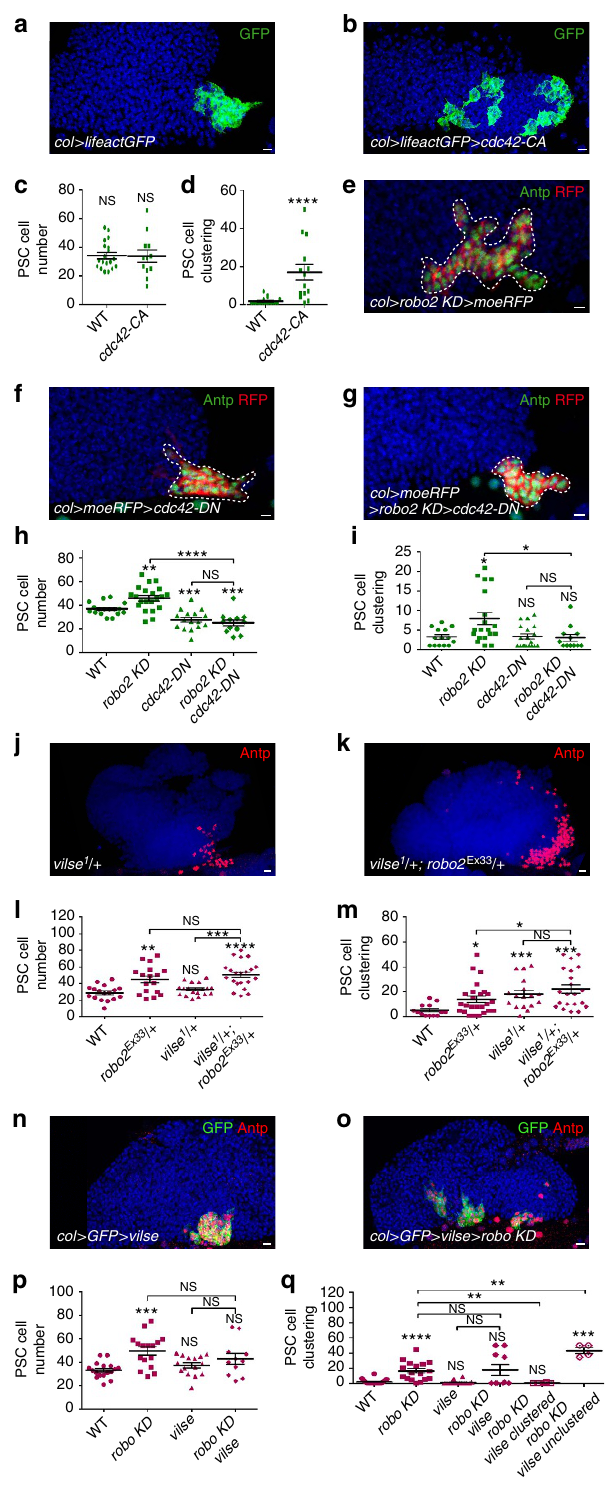
Figure 6 | Robo receptors control PSC cell clustering by repressing Cdc42 activity. ( a , b ) LifeactGFP (green) is expressed in PSC cells under the control of the col driver ( col 4 ) ( a ) and co-expressed with a constitutive form of Cdc42 (cdc42-CA) ( b ). ( c , d ) Quantification of PSC cell numbers ( c ) and PSC cell clustering ( d). ( e – g ) Antp (green) and RFP (col 4 moeRFP, red) label PSC cells in robo2 KD ( e ), when a dominant negative form of Cdc42 ( cdc42-DN ) is expressed ( f ) or when robo2 KD and cdc42-DN are co- expressed in the PSC ( g ). While the expression of cdc42-DN has no major effect on PSC cells ( f ), its co-expression in robo2 KD ( g ) rescues the robo2 KD PSC defect ( e ). ( h , i ) Quantification of PSC cell numbers ( h ) and PSC cell clustering ( i ). ( j , k ) Antp (red) labels PSC cells in vilse 1 / þ heterozygous mutant ( j ) and in vilse 1 / þ ; robo2 Ex33 / þ trans -heterozygous mutant ( k ). ( l , m ) Quantification of PSC cell number ( l ) and PSC cell clustering ( m ). A PSC cell clustering defect is observed in vilse 1 / þ heterozygous mutant. ( n , o ) Antp (red) labels PSC cells in col 4 vilse ( n ) and col 4 vilse 4 robo KD ( o ). ( p , q ) Quantification of PSC cell numbers ( p ) and PSC cell clustering ( q ). Averaging the clustering of all col 4 robo KD 4 vilse , LGs does not reveal a significant clustering defect (Fig. 6q). However, these LGs ( n ¼ 10 lobes) can be divided into two classes: clustered (60%) and unclustered (40%), revealing a partial rescue of PSC cell clustering defect. Statistical analysis t -test (Mann–Whitney nonparametric test) was performed using GraphPad Prism 5 software. Nuclei are labelled with Topro (blue). Scale bars, 10 m m.